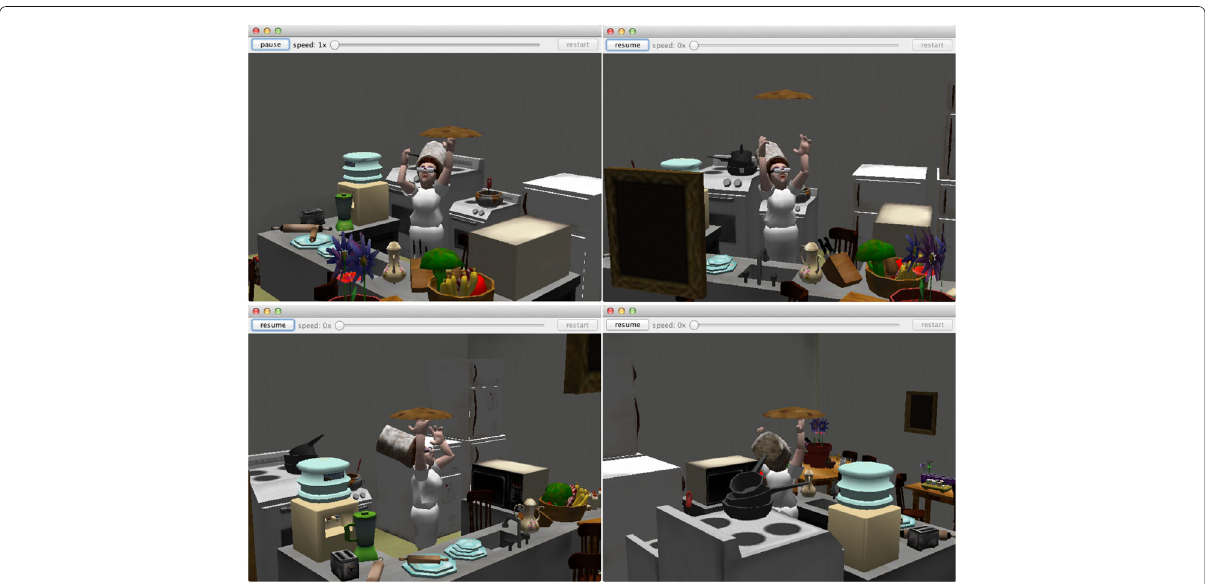
Fig. 16 As the subjective camera orbits (via phase-locked rotation and revolution) in an inspection gesture between mirrored and tethered perspectives around an objective character animated by real-life motion capture, the puppet automatically switches virtual manipulating hand to preserve alignment and logical